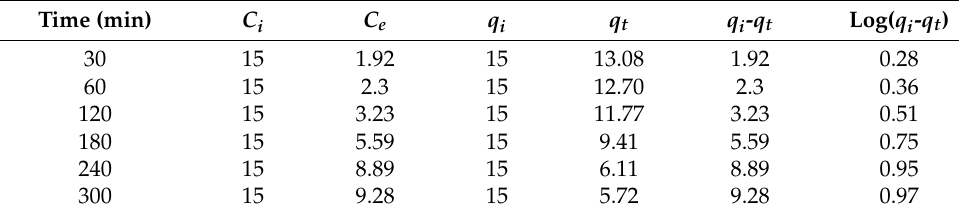
Table 3. Calculated values for kinetic